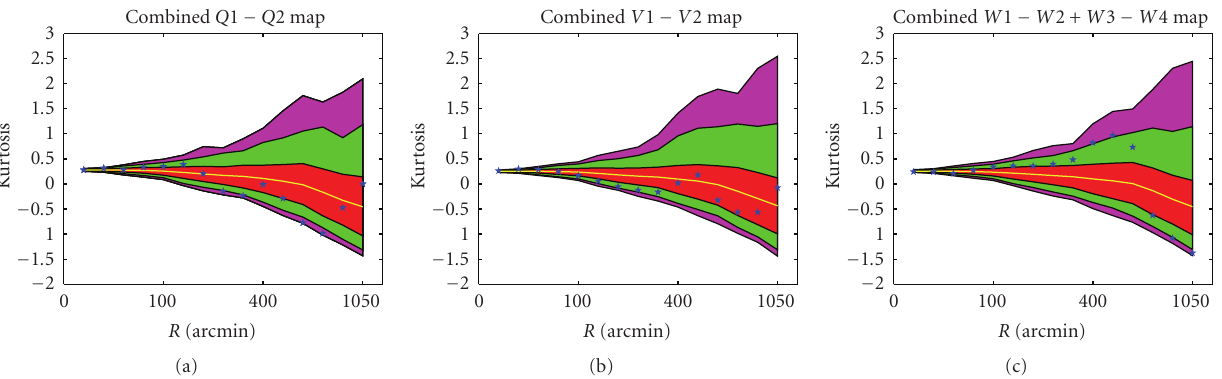
Figure 9: Null tests performed on di ff erence maps, free of any foreground and cosmological signal. (a) represents the kurtosis of the SMHW coe ffi cients, as a function of the scale R , for the Q 1 − Q 2 map, that is, for a map built as the di ff erence of the di ff erence assemblies observations at 41GHz. (b) is as the previous one, but for the V 1 − V 2 di ff erence map, that is, at 61GHz. Finally, (c) provides the variation of the SMHW coe ffi cients as a function of the wavelet scale, but for the di ff erence map obtained with the 4 di ff erence assemblies of WMAP at 90GHz, that is, W 1 − W 2+ W 3 − W 4. The blue asterisks represent values for the data whereas red, green and magenta regions represented the acceptance intervals at 32%, 5%, and 1%, respectively, determined by simulations.